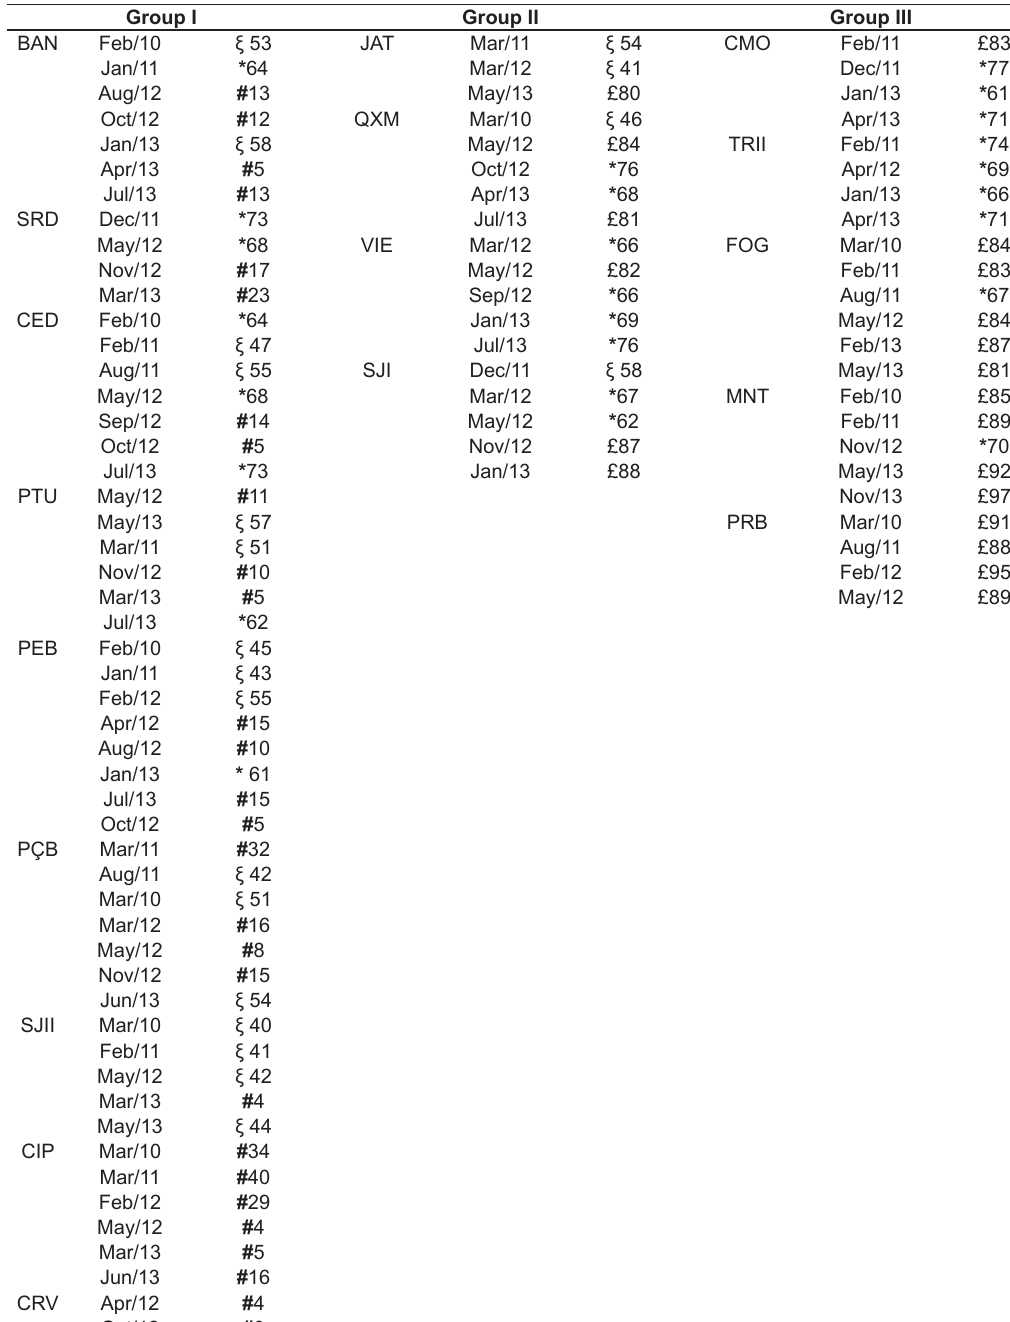
Table 5. Matrix of Water Trophic Quality of the groups formed from the Multivariate Analysis/Hierarchical Cluster Analysis of the Banabuiú basin reservoirs.